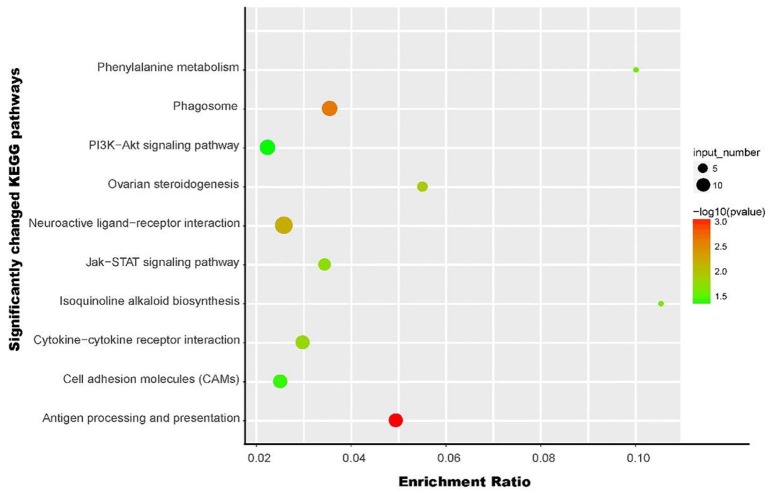
An overview of the significantly affected pathways from KEGG analysis in this study. The y-axis indicates specific pathways, and the x-axis indicates the enrichment ratio. The size of the colored dots indicates the number of significantly changed genes involved into each corresponding pathway, and pathways with larger-sized dots contain a higher number of genes. The color of the dots shows the –log p-value of the pathways.